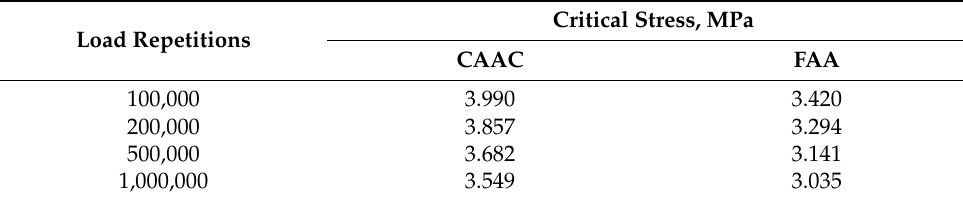
Table 6. The critical stresses for different load